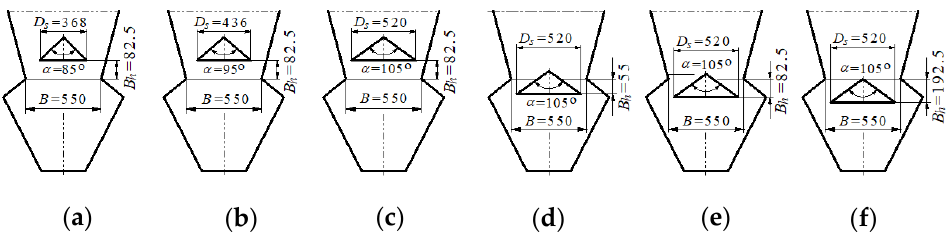
Figure 21. Examples of variants of analyzed geometric configurations of the counter cone [86]. ( a – c ) —cones with different values of angle α at the same height B h above the diameter of the lower (dust) outlet of the cyclone, ( d – f ) —cones with the same value of angle α at different heights B h below the diameter of the lower (dust) outlet of the cyclone.